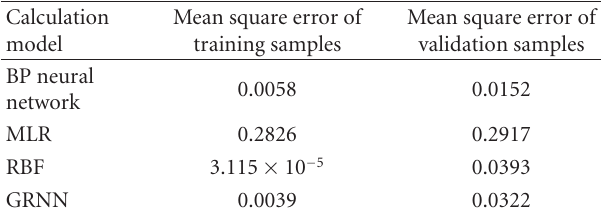
Table 3: Mean square error comparison among the four calculation models.